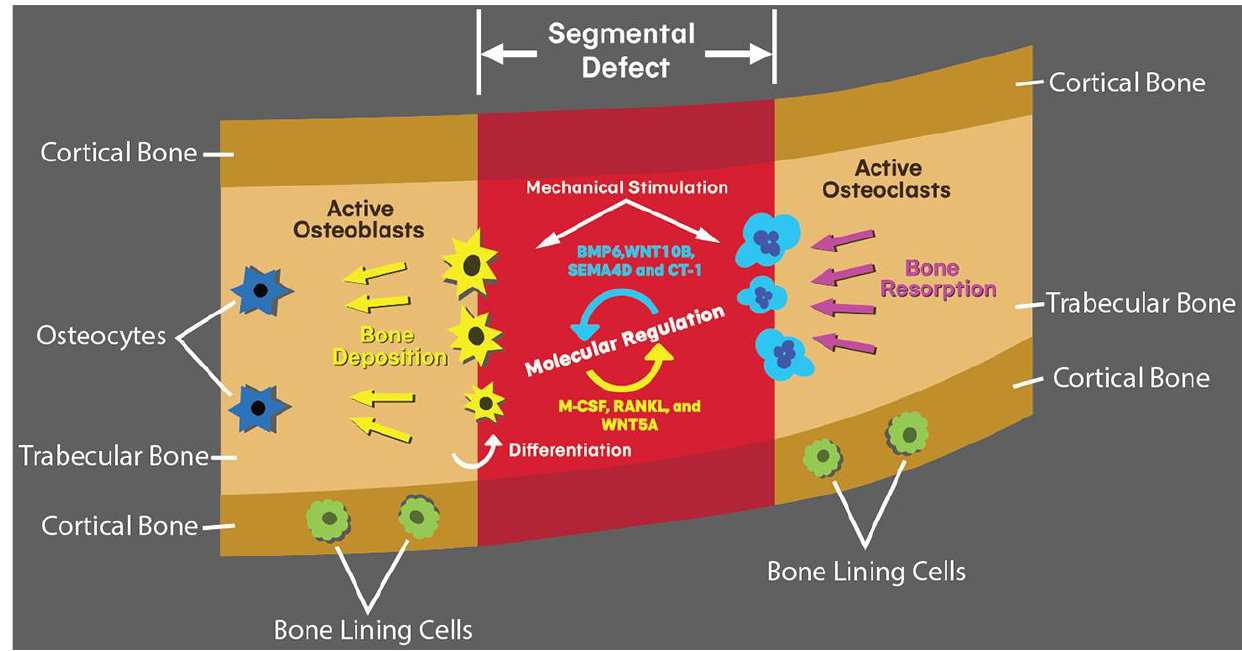
Figure 1. Actions of osteoclasts, osteoblasts and bone lining cells in the context of a segmental mandibular defect. Selected molecular mechanisms of regulation between osteoblasts and osteoclasts include BMP6, WNT10B, SEMA4D, CT-1, M-CSF, RANKL, and WNT5A. Cellular activity of these cells is regulated by juxtacrine and paracrine signalling. Osteoclast activation is achieved by osteoblast expression of macrophage -colony stimu- lating factor M-CSF, receptor activator of nuclear factor kappa- β ligand (RANKL), and Wnt gene family 5A (WNT5A), while the reverse is activated by osteoclast expression of bone morphogenetic protein 6 (BMP6), Wnt gene family 10B (WNT10B), Semaphorin 4D (SEMA4D) and Cardiotrophin-1 (CT-1)